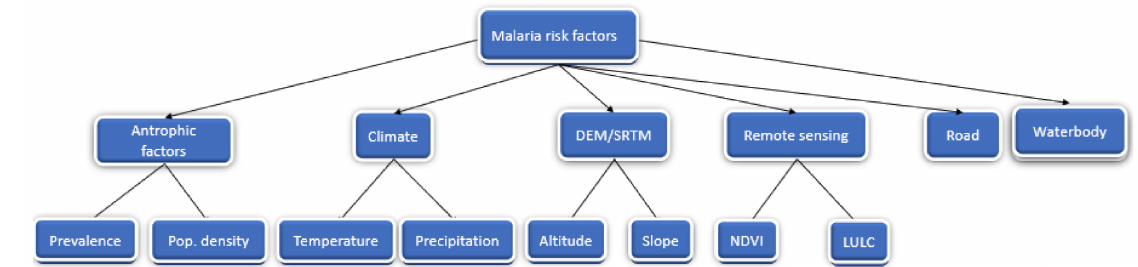
Figure 3. Representation of malaria risk factors and their flow for malaria risk map generation for Sussundenga Village. DEM/SRTM = Digital elevation model/Shuttle Radar Topographic Mission, NDVI = Normalized difference vegetation index, LULC = Land use and land cover.